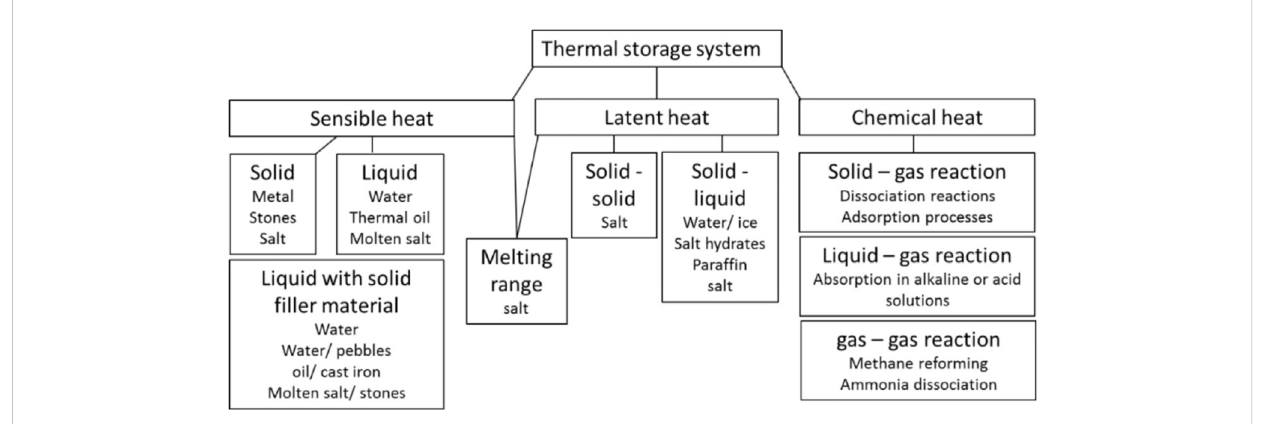
FIGURE 2 Thermal energy storage overview (Source: https://www.beilstein-journals.org/bjnano/content/ fi gures/2190-4286-6-154-1.png?scale=2.0&max- width=1024&background=FFFFFF).